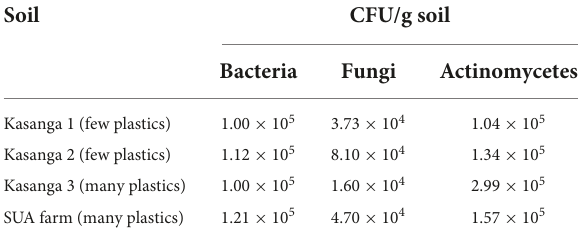
TABLE 1 Microbial populations of the studied soils. Soil CFU/g soil Bacteria Fungi